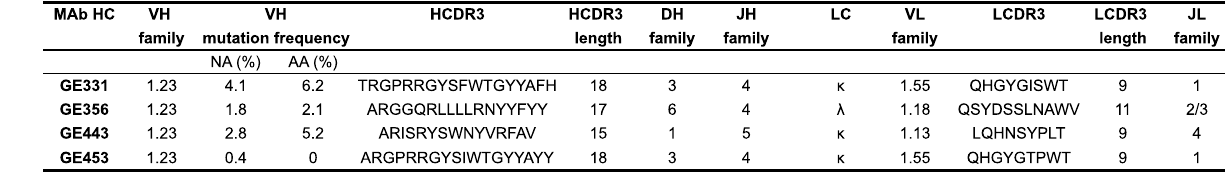
Figure 4. Genetic analysis of the isolated VH1.23-using CD4bs-specific MAbs. (A) Sequence alignments of the isolated NHP VH1.23-using MAbs. The framework regions (FR) are boxed in gray and the amino acid differences compared to the germline VH1.23 sequence are highlighted in yellow. Depicted below the MAb sequences is the newly discovered VH1.23*02 germline allele. (B) Alignments of the GE356 heavy and light chain sequences with the assigned germline sequences. (C) Summary of the genetic characteristics of the VH1.23 vaccine-induced MAbs.